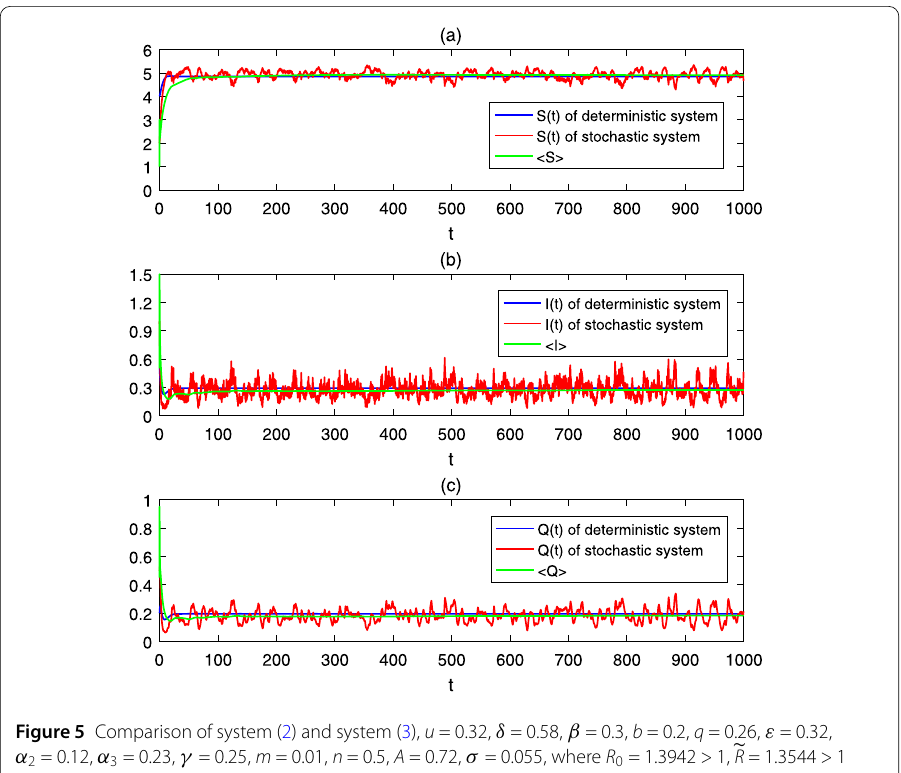
Figure 5 Comparison of system (2) and system (3), u = 0.32, δ = 0.58, β = 0.3, b = 0.2, q = 0.26, ε = 0.32, α